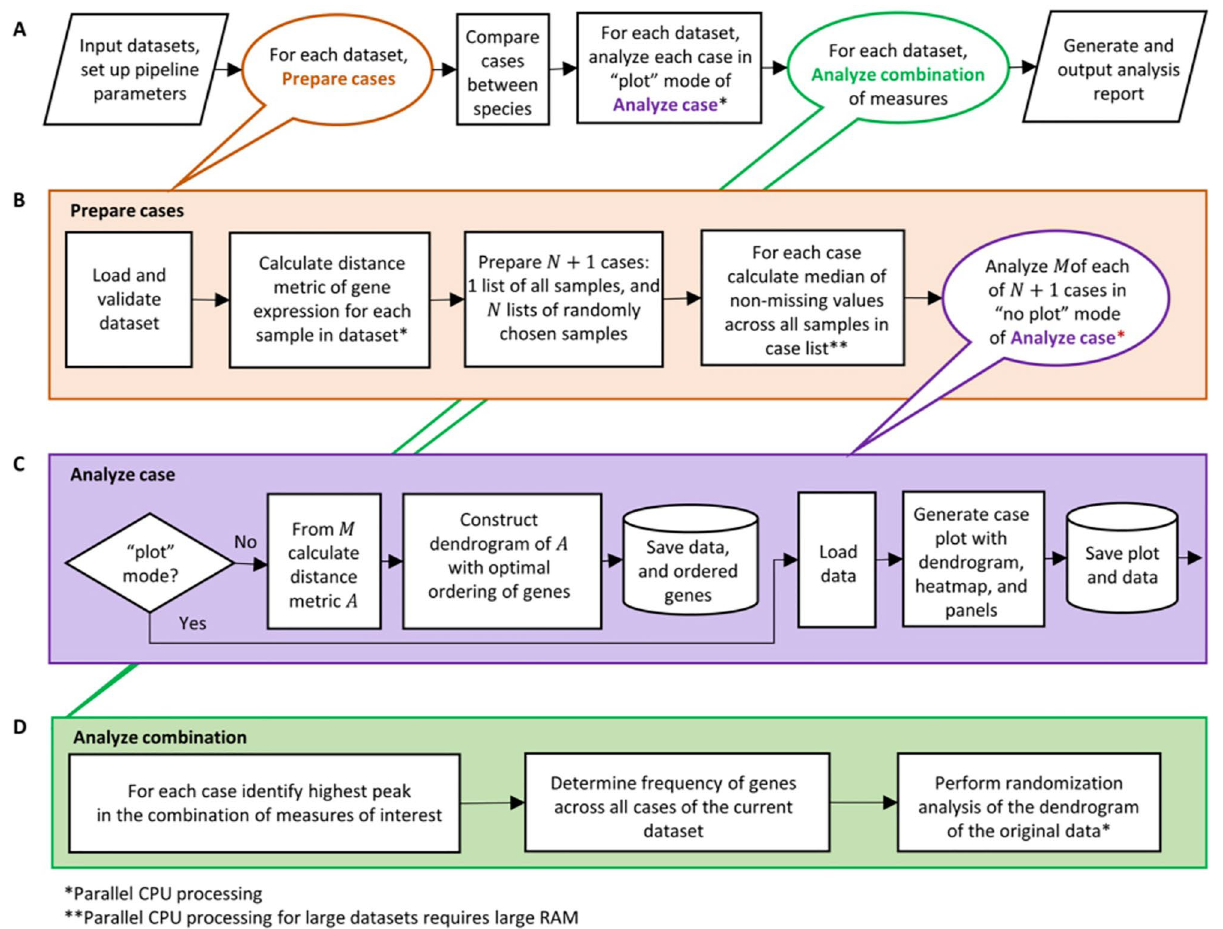
Figure 6. Summary of the analysis pipeline. Normalized single cell transcriptomics datasets are processed in steps depicted in panel ( A ). The principal steps of the pipeline are outlined in panels ( B ), ( C ) and ( D ). An analysis report is generated at the end of the